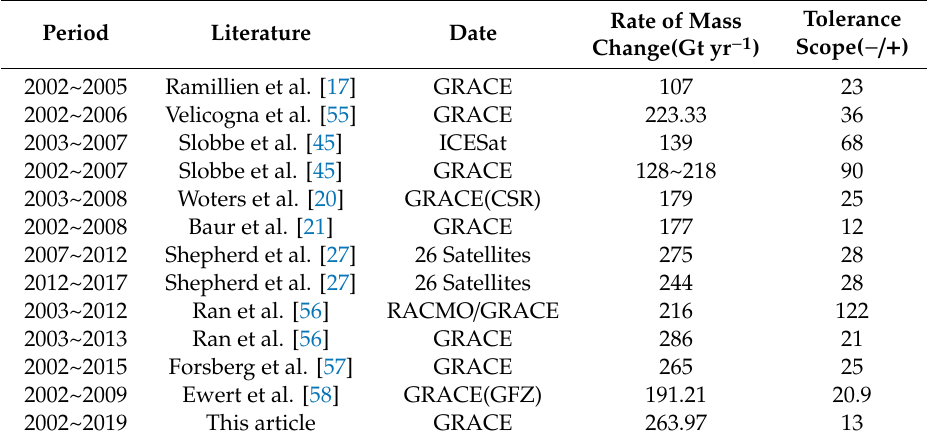
Table 1. Comparison of estimated mass change trends in